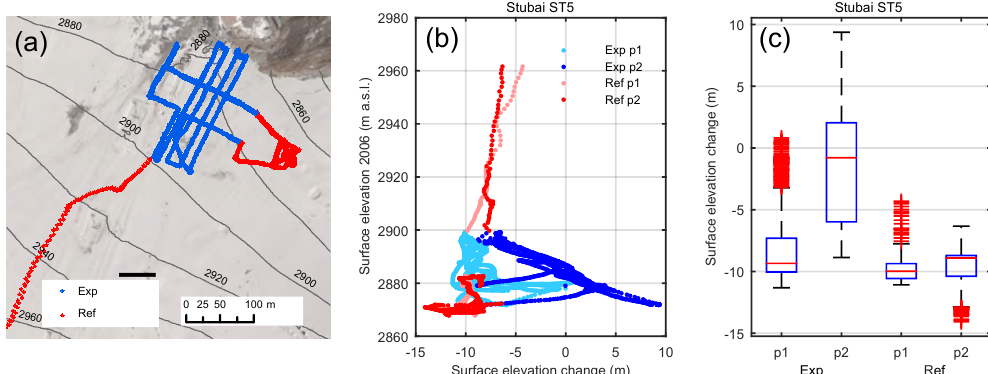
Figure 4. (a) Location of profile ST5, (b) surface elevation changes plotted for surface elevation in 2006, and (c) boxplot of surface elevation changes along the profile separated into experimental areas (exp; in blue) and reference areas (ref; in red) for the periods without (p1; in light colour) and with (p2; in dark colour) mass balance management. Note that similar plots for each profile are provided in the Supplement.